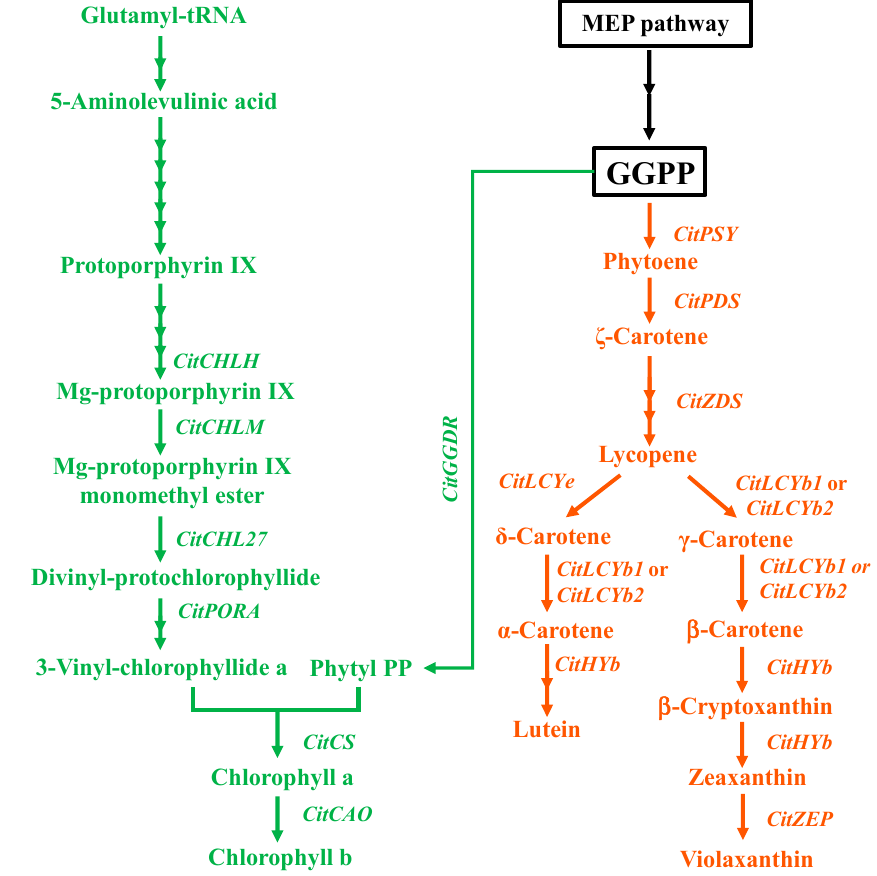
Figure 1. The biosynthetic pathways of chlorophyll and carotenoid from methylerthritol-4-phos- phate (MEP) in plants. MEP pathway, methylerthritol-4-phosphate pathway; GGPP, geranylgeranyl